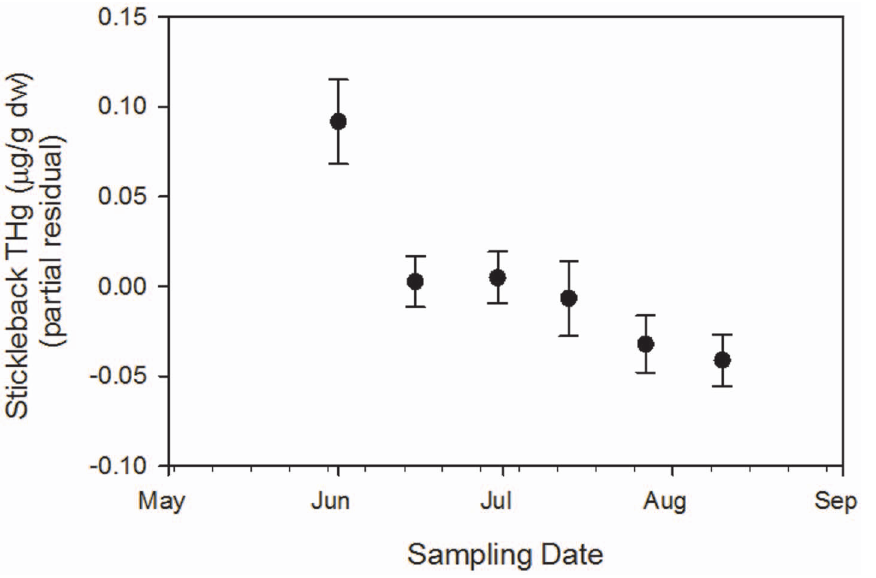
Figure 4. Partial residuals of total mercury (THg) concentrations ( ± SE) in threespine stickleback collected bi-monthly from two lakes at Agattu Island, Aleutian Archipelago, Alaska, 2011. The partial residuals account for other variables in the global mixed-effects model.